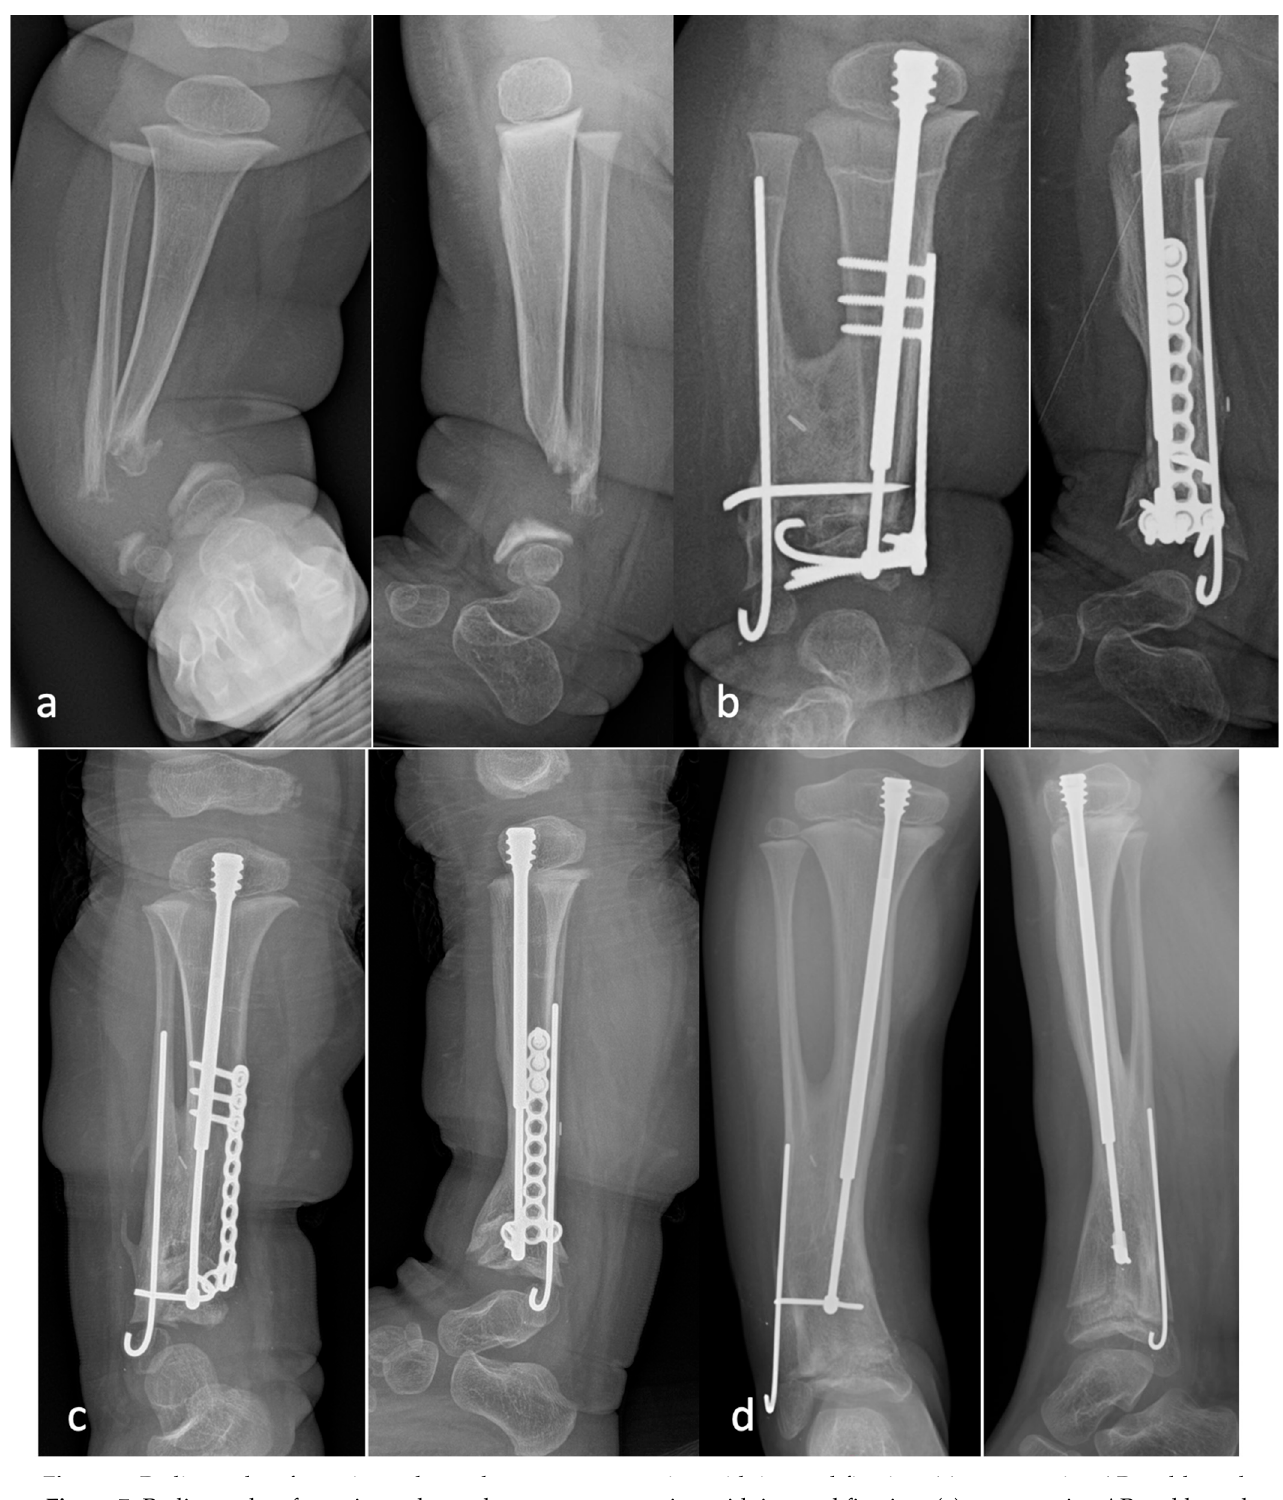
Figure 7. Radiographs of a patient who underwent a cross-union with internal fixation: ( a ) preoperative AP and lateral radiographs demonstrating a large bone defect and small distal metaphyseal segments of the tibia and fibula (Type 4C); ( b ) AP and lateral radiographs taken 12 weeks after surgery show a well-healed cross-union with bridging between the tibia and fibula, as well as filling of the bony defects; ( c ) AP and lateral radiographs taken 1 year after surgery with growth of the bone at both ends and telescoping of the FD rod to the level of the cross-union; ( d ) AP and lateral radiographs taken at 2.5 years after surgery, after a one-rod exchange, with a solid cross-union and no refracture.